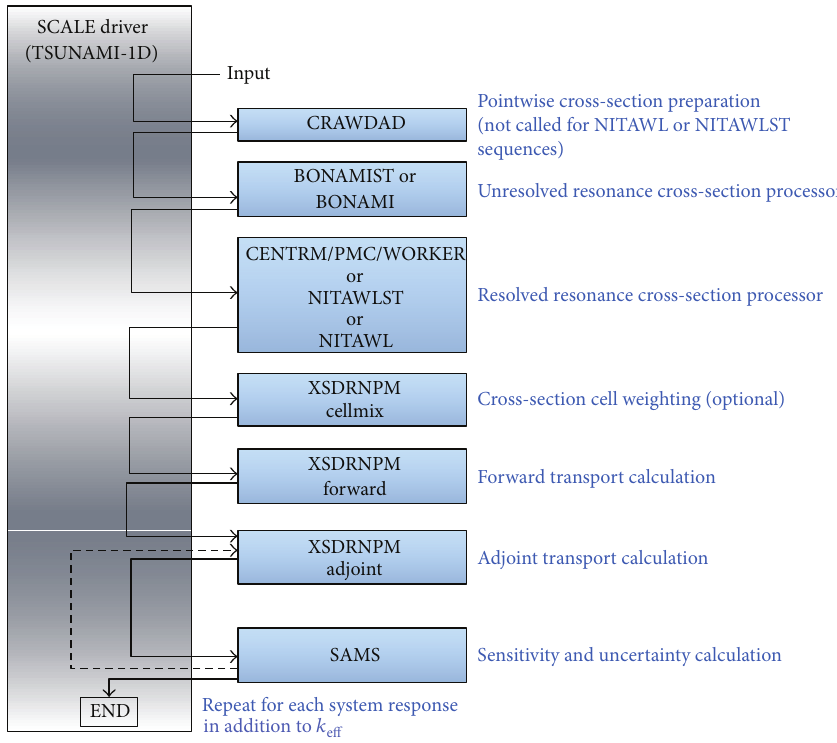
Figure 3: General flow diagram of the TSUNAMI code